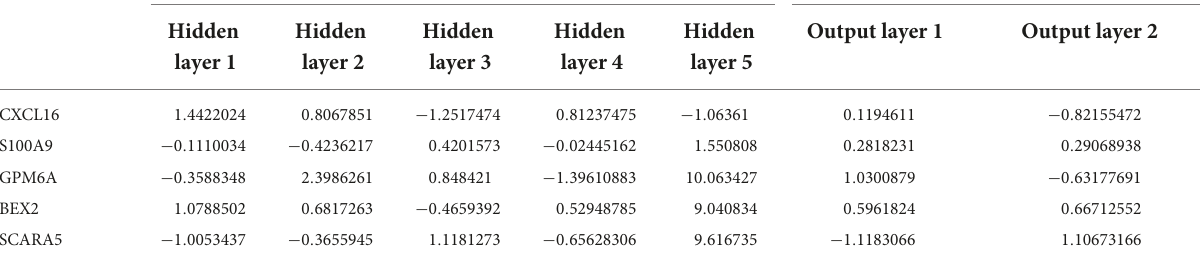
TABLE 4 Gene weights of five markers for all samples of the combined dataset of GSE12644 and GSE51472. The weight of genes in the hidden layer The weight of genes in the output layer Hidden Hidden Hidden Hidden Hidden Output layer 1 Output layer 2 layer 1 layer 2 layer 3 layer 4 layer